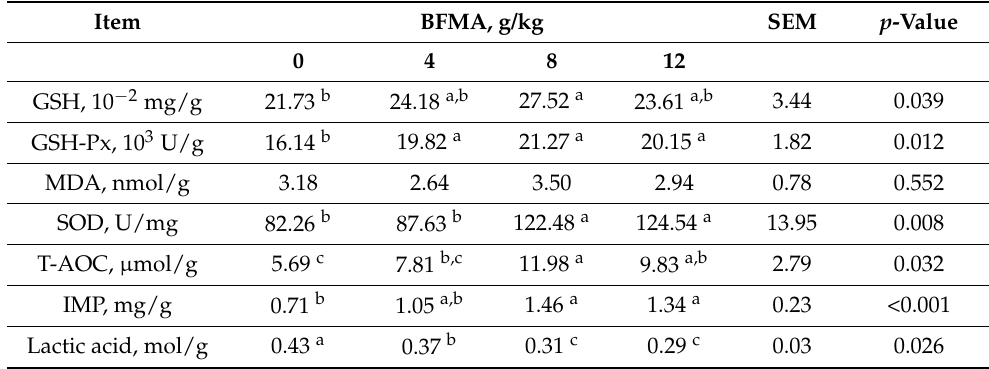
Table 6. Effects of dietary malic acid on antioxidant capacity of breast muscle of broilers.